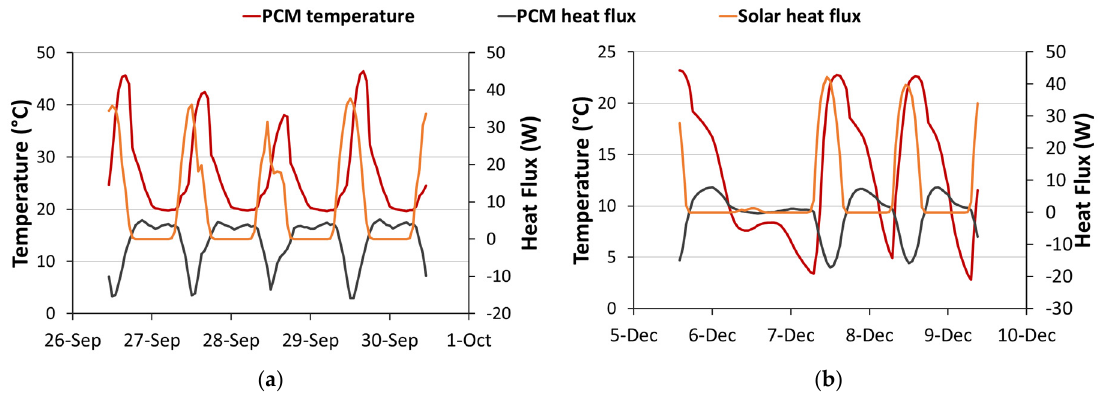
Figure 7. Heat flux of PCM and of incoming solar radiation and temperature trend of the PCM: ( a ) warm season campaign; ( b ) cold season campaign.